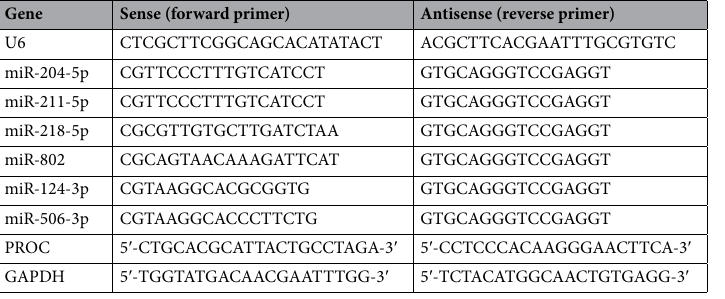
Table 1. Primer sequences for